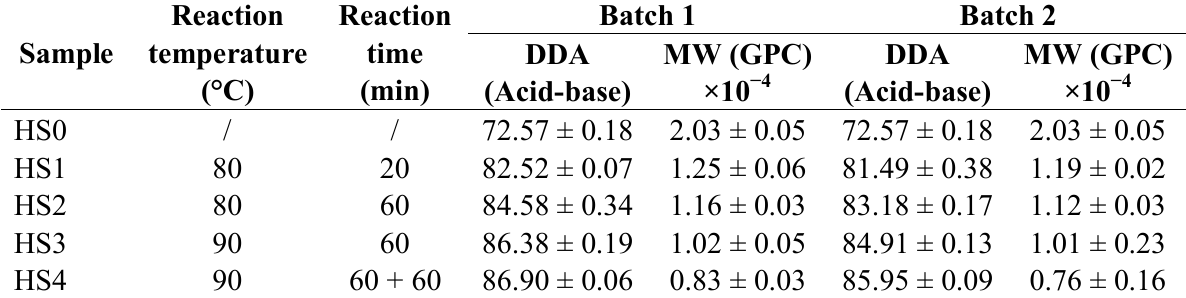
Table 2. Chitosan deacetylation reaction under nitrogen atmosphere (batch 1 and